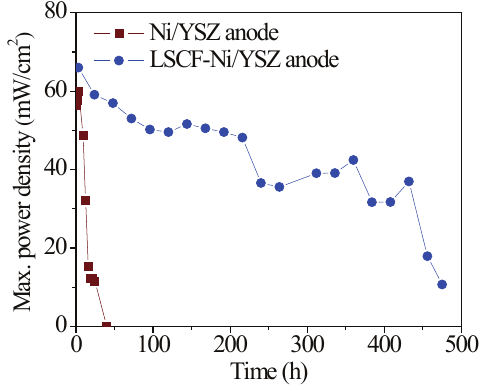
(100 sccm, 25 vol% CH 4 4